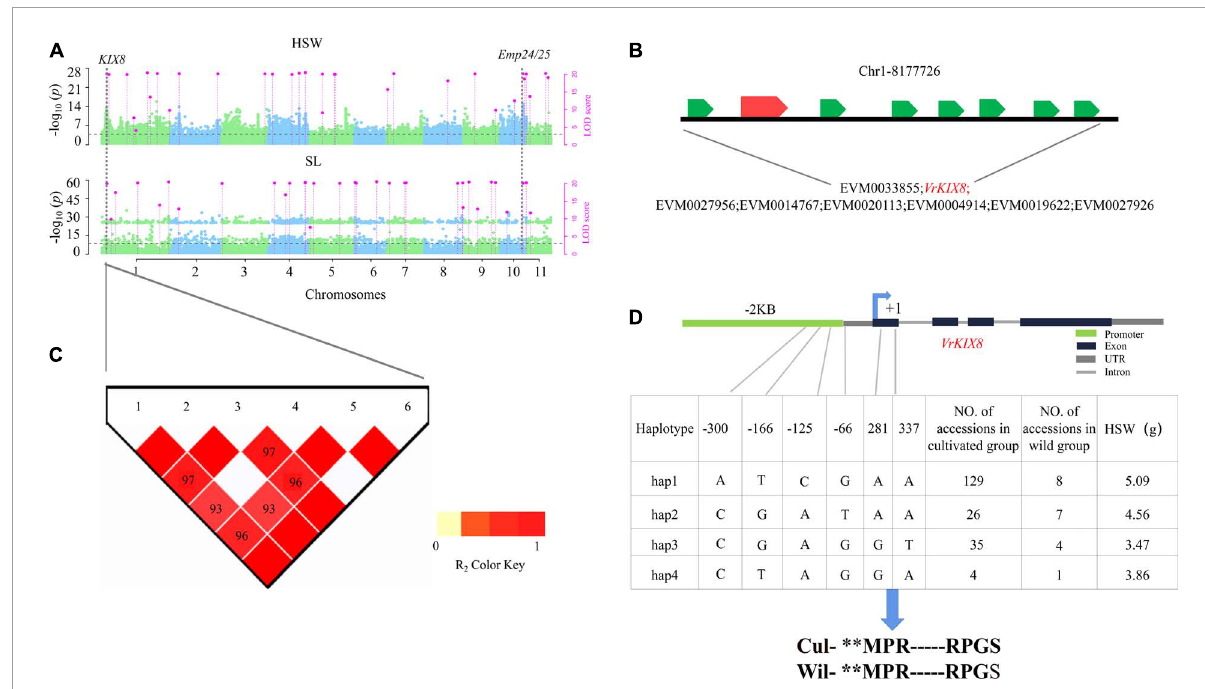
FIGURE5 Genetic analysis of VrKIX8 . Local Manhattan plots for HSW in multi-environments. LOD ≥ 3.0 for the 3VmrMLM as the significant QTN (A) . LD heatmaps surrounding Chr1-8161305-8347626 loci (B) . Genes around the significant QTN region, shown at the bottom (C) . Haplotype analysis of VrKIX8 (D) . Wil, the wild accessions. Cul, the cultivated accessions. symbol “**” means omit the same sequence part.